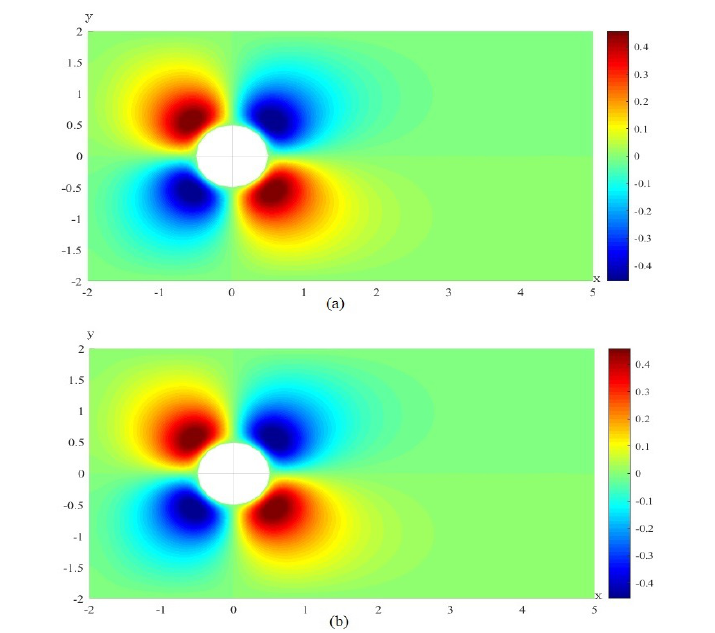
at t = 5. ( b ) The RDR-CNMFE solution u n h